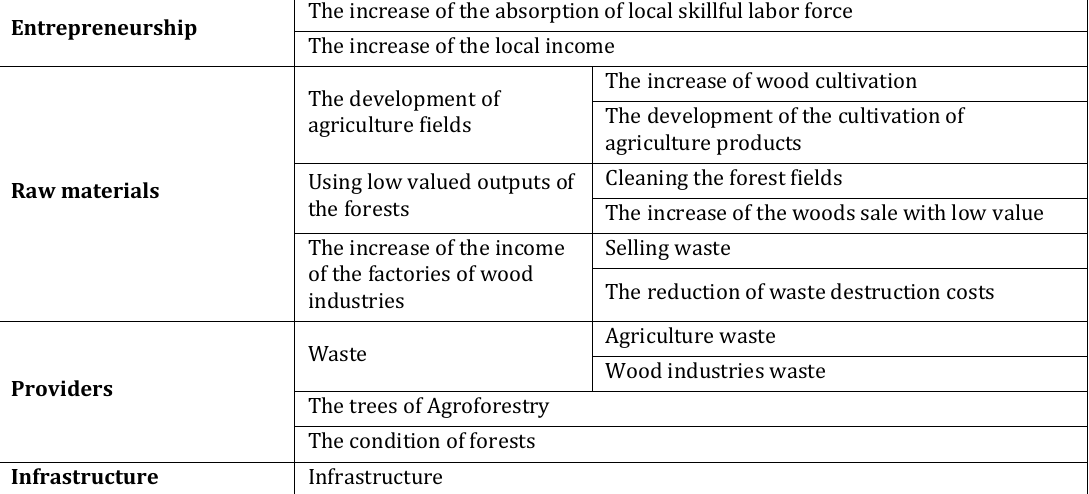
Table 3: The main criterion of the benefits for site selection of new energy production from cellulosic